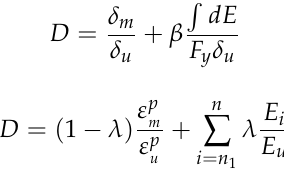
(4) Table 4. Parameter values of initial loading curve. Base Metal ( b ) Figure 11. Fitting results of the initial loading curve. ( a ) The schematic diagram of the initial loading curve; ( b ) Fitting result of the WA1 specimen.